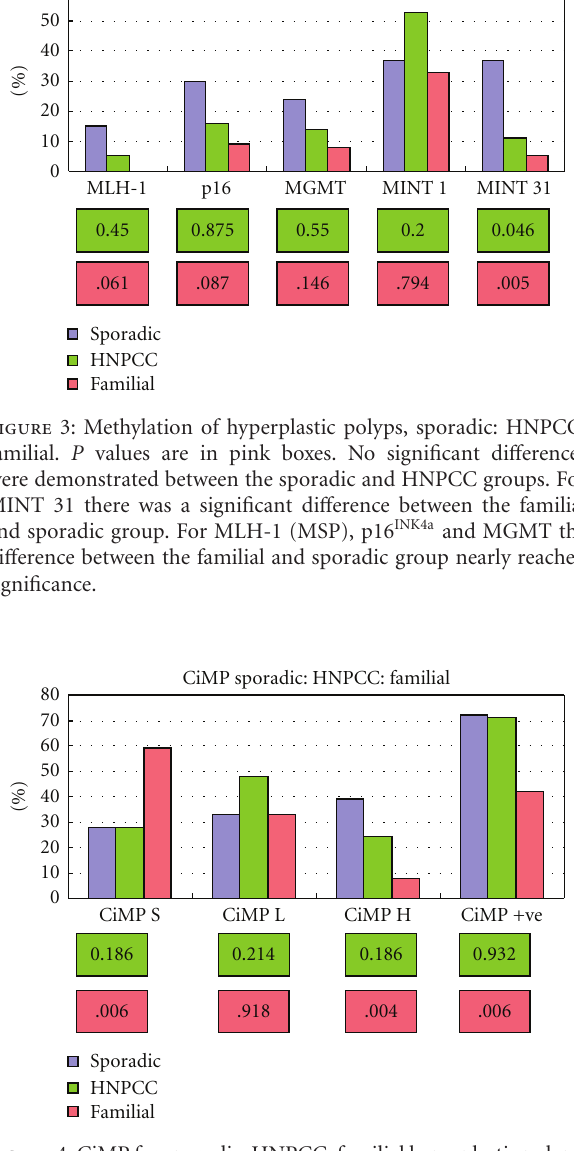
Figure 4: CiMP for sporadic: HNPCC: familial hyperplastic polyps. P values (Chi 2 ) in pink boxes. No significant di ff erence were observed between the sporadic and HNPCC group (olive boxes). Comparing the pattern of methylation after scoring CiMP for the sporadic and familial groups demonstrated a significant di ff erence for CiMP H and overall CiMP positive status (pink